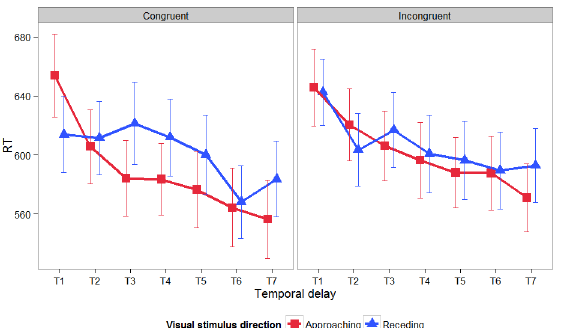
Fig 2. Mean RTs to the nociceptive targets and their associated standard errors in function of the different temporal delays at which the nociceptive stimuli were administered (from T1 to T7), the direction of the visual stimulus (approaching vs. receding) and the congruency of the nociceptive stimulation (congruent vs. incongruent to the visual